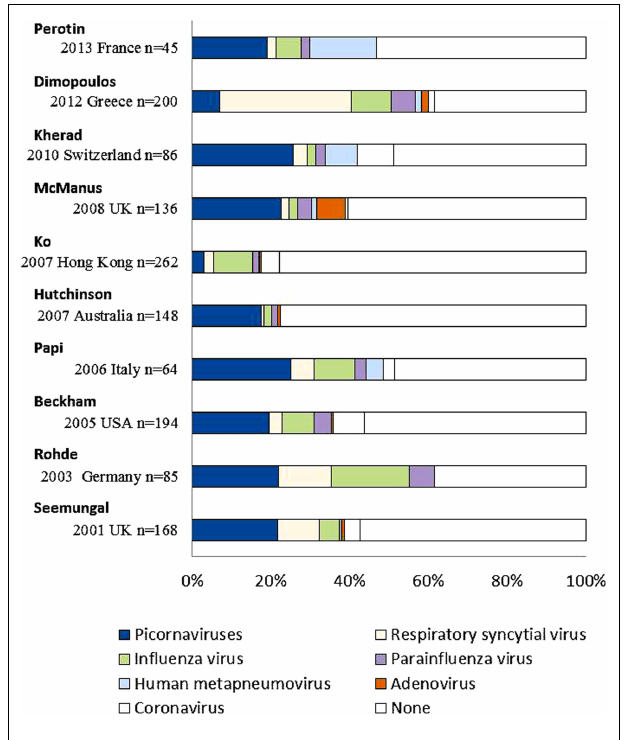
FIGURE 4 |Viral detection in exacerbations of COPD using PCR or RT-PCR methods in recent studies. Picornaviruses include human rhinovirus and human enterovirus. Multiple viruses were detected in individual patients per one